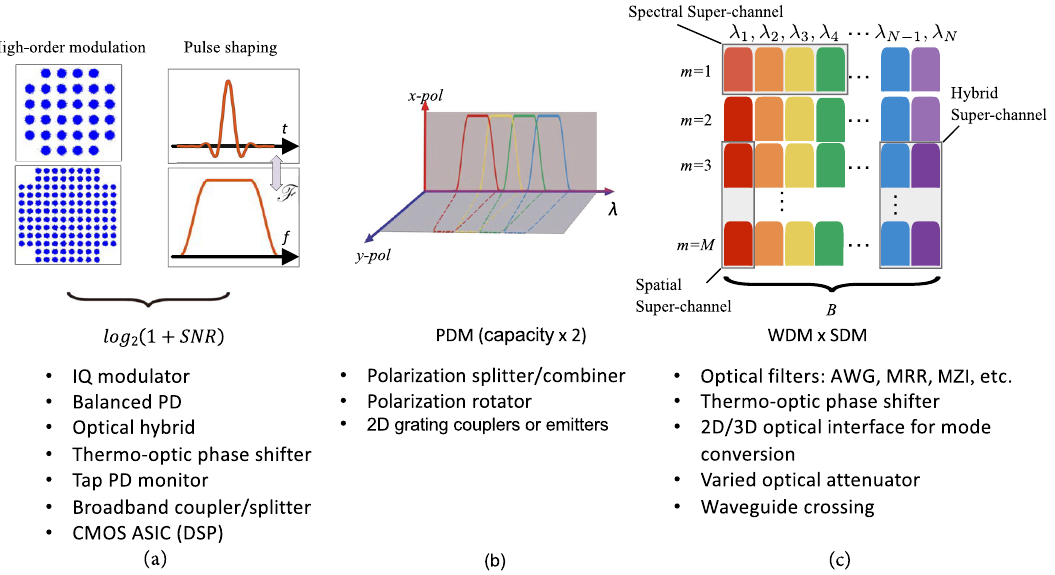
Figure 2: Scaling the transmission capacity of an optical link in various dimensions, following Eq. (1), including (a) augmenting the spectral ef fi ciency through higher modulation formats with coherent detection (quadrature) and pulse shaping (time); (b) capacity doubling by PDM (polarization); (c) WDM × SDM(frequency and space). The required PIC building blocks are listed under respective functions. WDM, wavelength- division multiplexing; SDM, space-division multiplexing; PDM, polarization-division multiplexing; PIC, photonic integrated